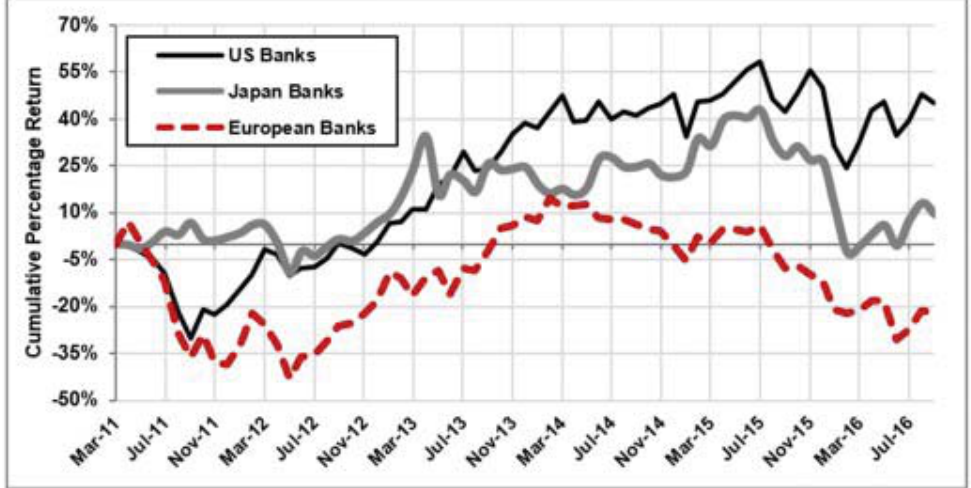
Fig. 1. Compound Stock Returns to U.S., European and Japanese Banks, 2011-2016